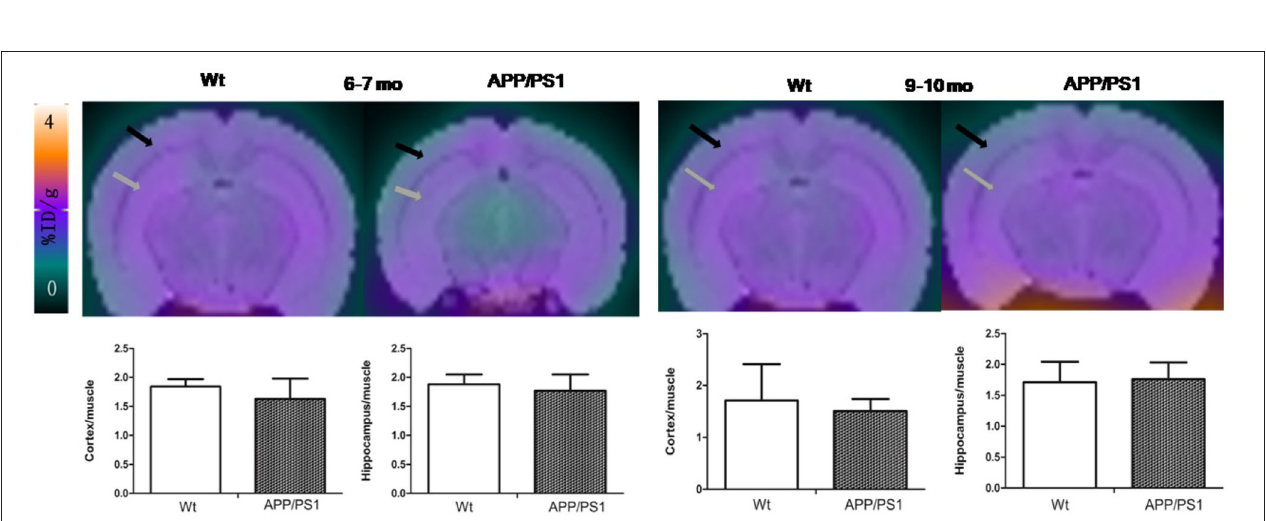
FIGURE 4 | The PET images were aligned with mice brain MRI template atlas. We selected hippocampus and cortex as the VOIs and calculated their percentages of injected dose per gram (%ID/g). PET/MRI template atlas fusion images and graphs representing [ 18 F]DPA714 signals in APP/PS1 vs. Wt mice 6–7 ( n = 8) and 9–10 ( n = 8) months of age. Black and gray arrows point to cortex and hippocampus, respectively.